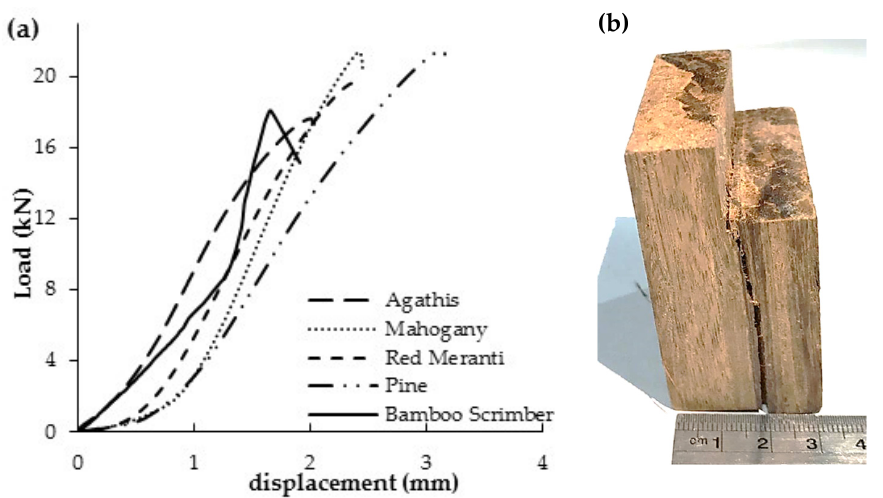
Figure 8. Shear parallel-to-fiber ( a ) results and ( b ) specimen failures in bamboo scrimber.